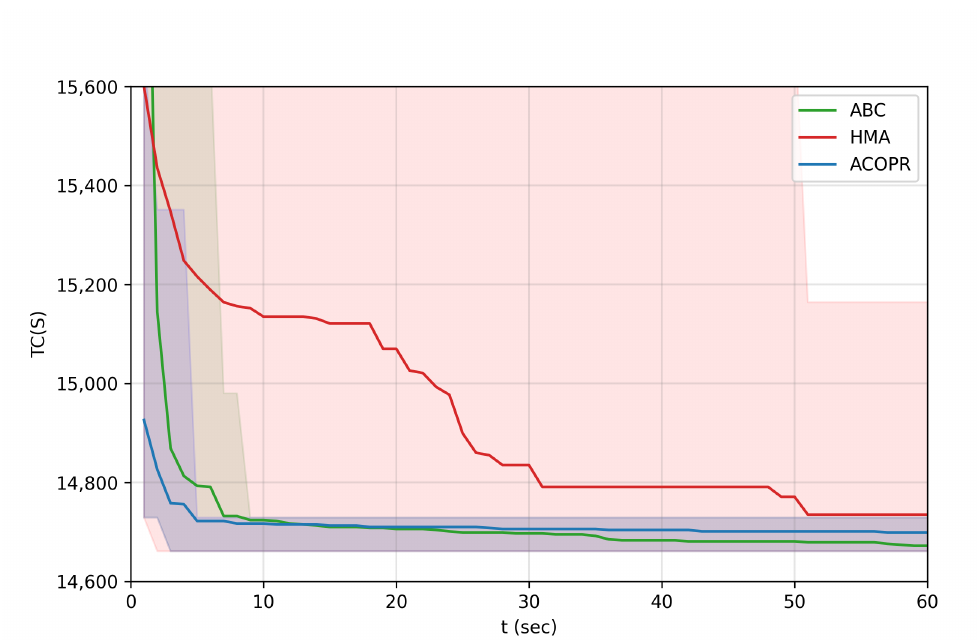
Figure 7. The convergence speed of 30 independent runs of HMA, ACOPR, and ABC algorithms on the “kshs1” instance, plotted on one chart.